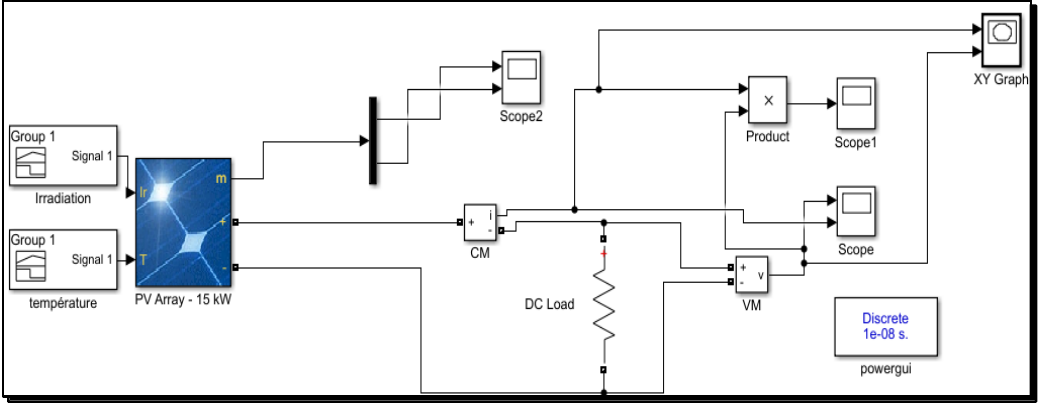
Figure 4. Block diagram used during simulation by ISIS.